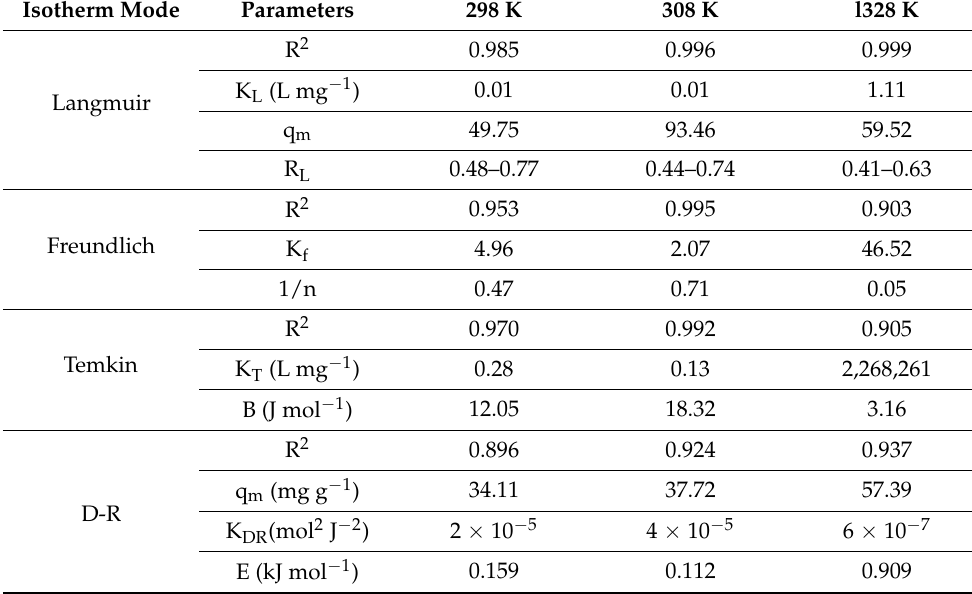
Figure 23. Schematic illustration of the interaction of CR dye with 2Clph-BU-Cs adsorbent.